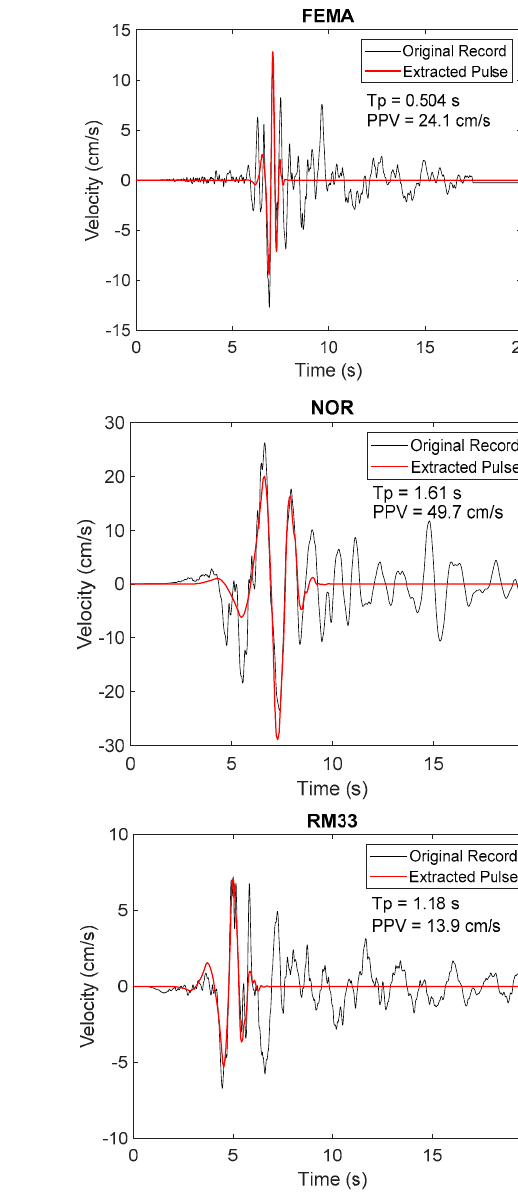
Figure 4. Velocity time series (black plots) and extracted pulses (red plots) of the fault normal (FN) components of the 6 seismic stations selected among those which recorded the strong ground motion on 24 August